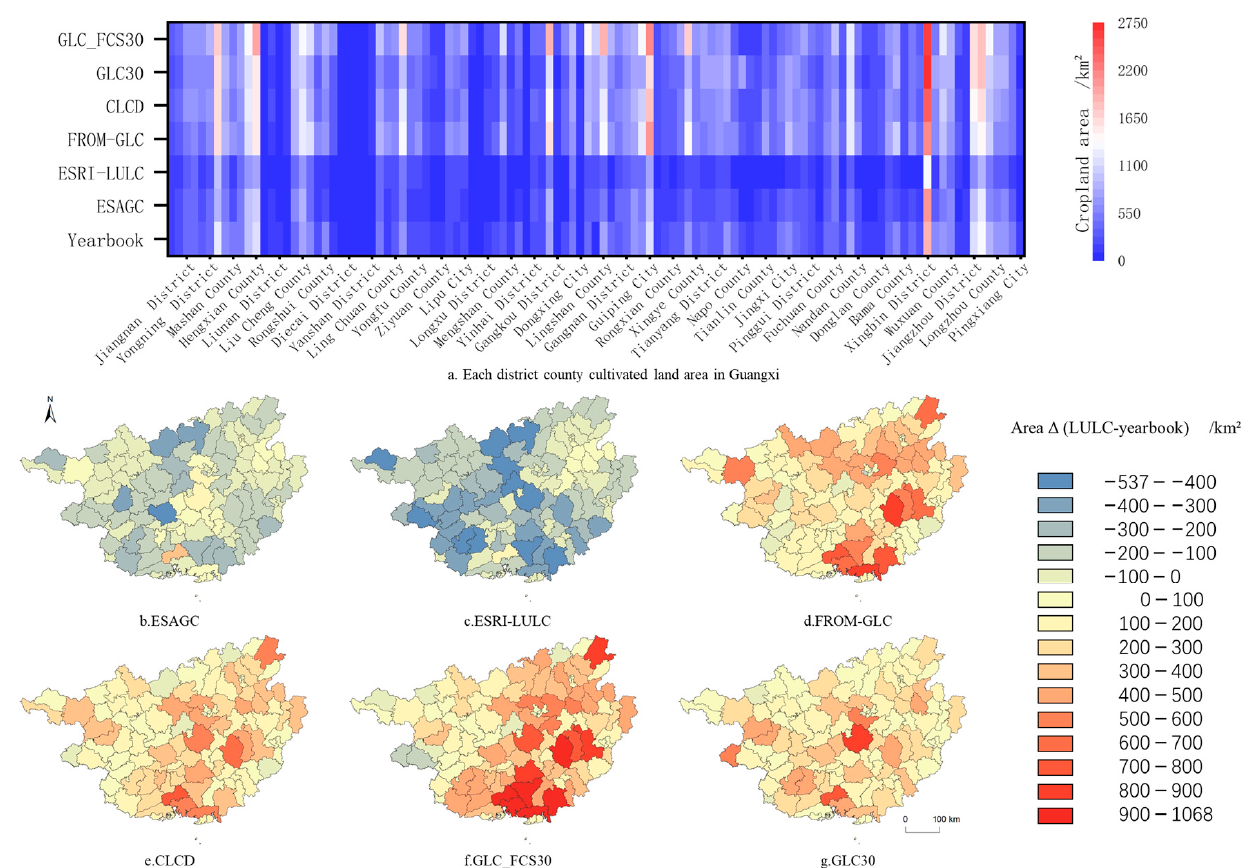
Figure 7. Area of cropland at the county-level according to the six land cover products and the statistical yearbook data: ( a ) heat diagram showing the area of cropland in each county in Guangxi for each data set; ( b – g ) the difference in cropland area between the different land cover data sets and the yearbook values.